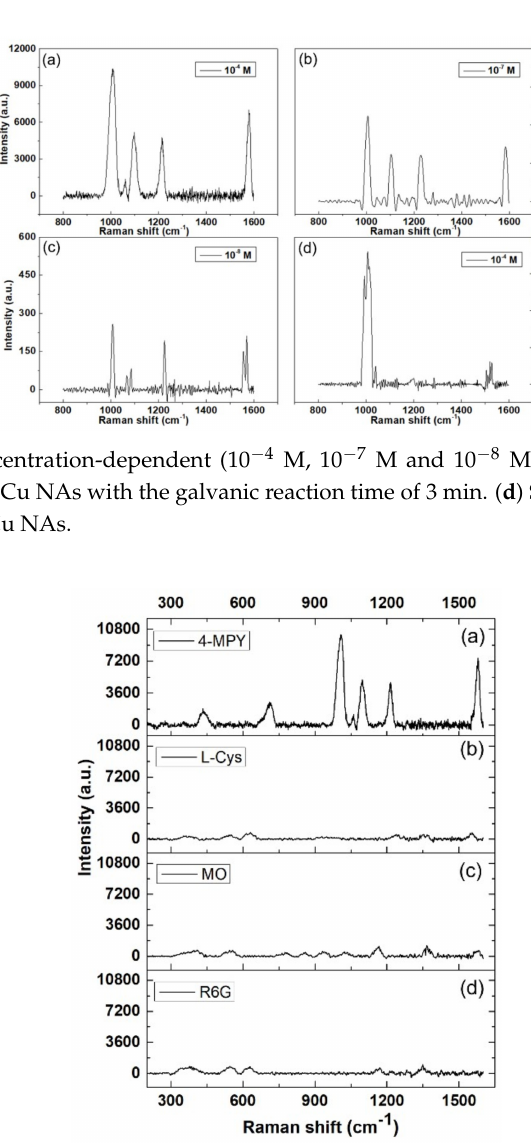
Figure 6. Selectivity of the SERS substrate with galvanic reaction time of 3 min. The concentrations of ( a ) 4-Mpy, ( b ) l-cysteine (L-Cys), ( c ) methyl orange (MO) and ( d ) rhodamine 6G (R6G) are 10 − 4